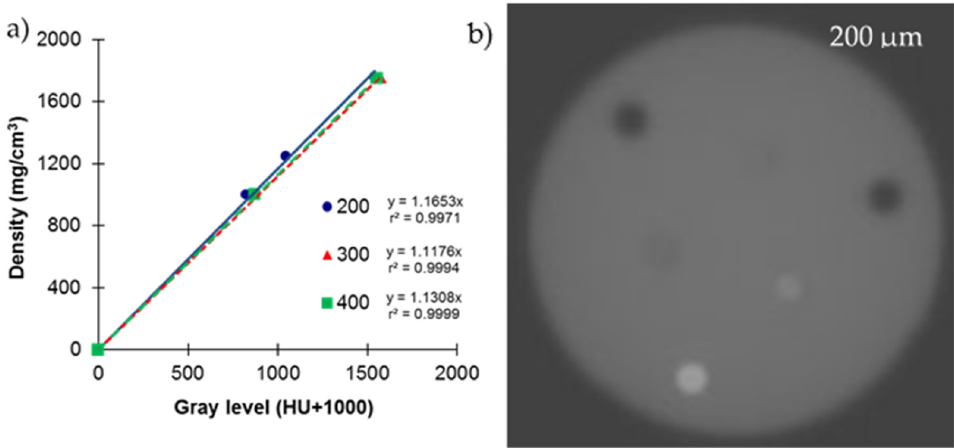
Figure 1. ( a ) Strong positive correlations in the calibration curves of gray values for ( b ) phantoms of bone materials (hydroxyapatite) with three different densities (1000, 1250, and 1750 mg/cm 3 ) scanned using three different resolutions (200, 300, and 400 μ m) of CBCT (Reprinted with unre- stricted permission for non-commercial use)